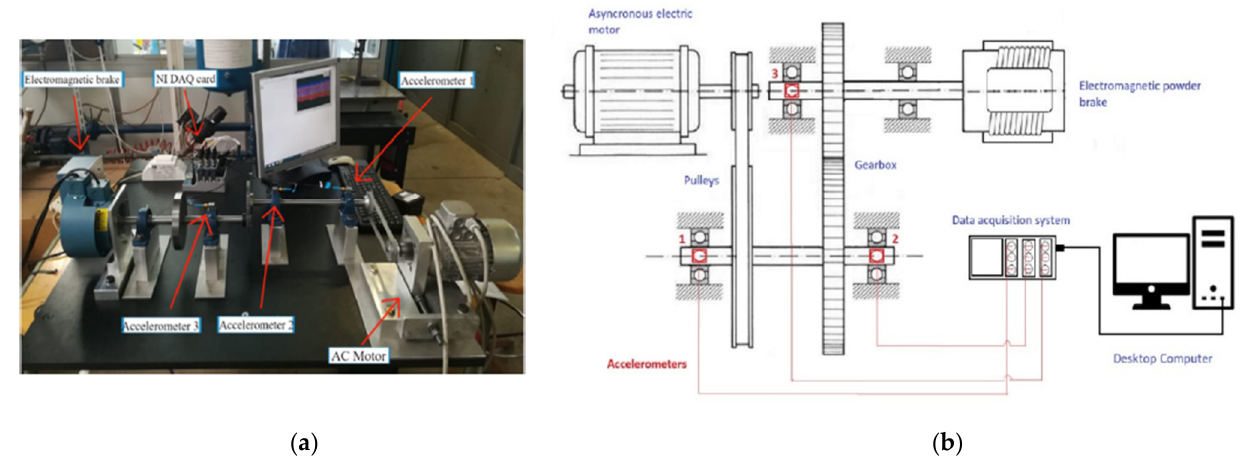
Figure 1. ( a ) The test rig and ( b ) its mechanical scheme.